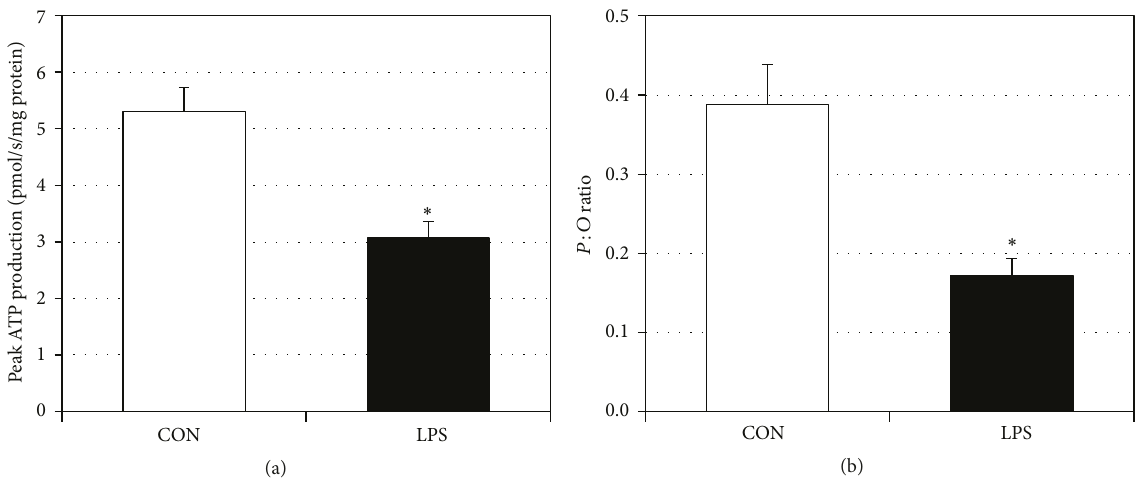
Figure 3: LPS reduces ATP production in HGF-1 cells. To determine ATP production following LPS treatment ((a), 5 𝜇 g/mL for 48 h), Magnesium Green fluorescence (503/530 nM) was determined during respiration after calibration with ADP (2.5 mM) ( 𝑛 = 3 ). The rate of peak ATP production was then compared against the rate of oxygen consumption to determine the P: O ratio ((b), 𝑛 = 3 ). ∗ 𝑃 < 0.05 .